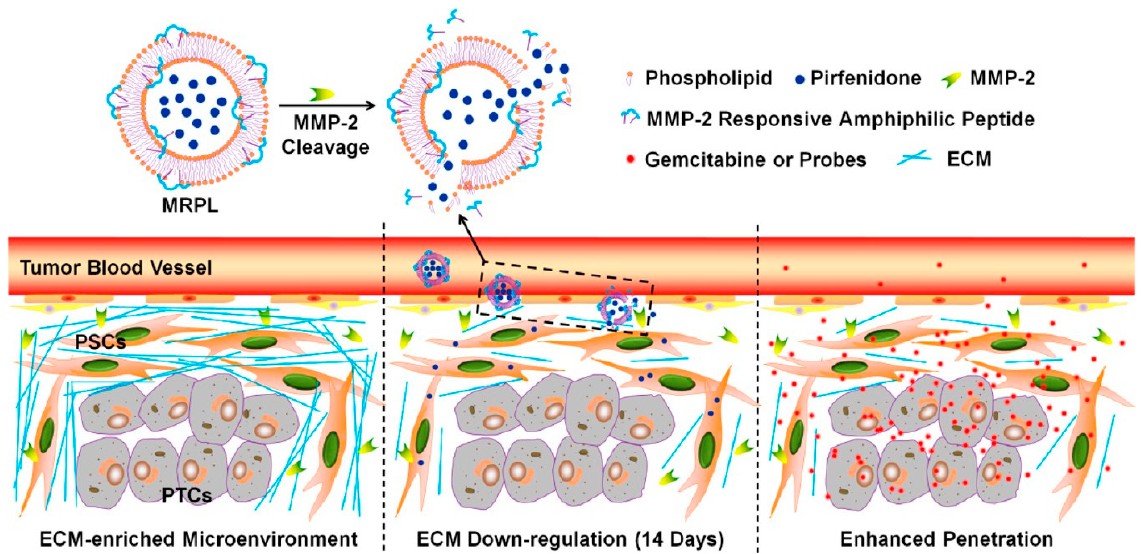
Figure 2. Suggested action mechanism of MMP-2 Responsive Peptide Hybrid Liposome (MRPL) for down-regulation of ECM in pancreatic tumors. Re-printed with permission from reference [99]. Copyright (2017), American Chemical Society.